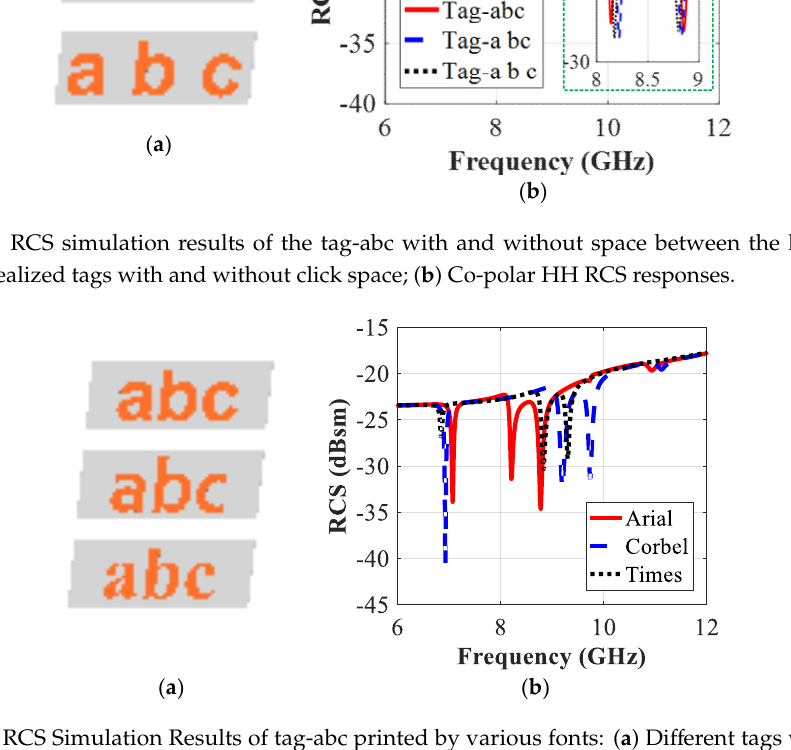
Different realized tags with and without click space; ( b ) Co-polar HH RCS responses.